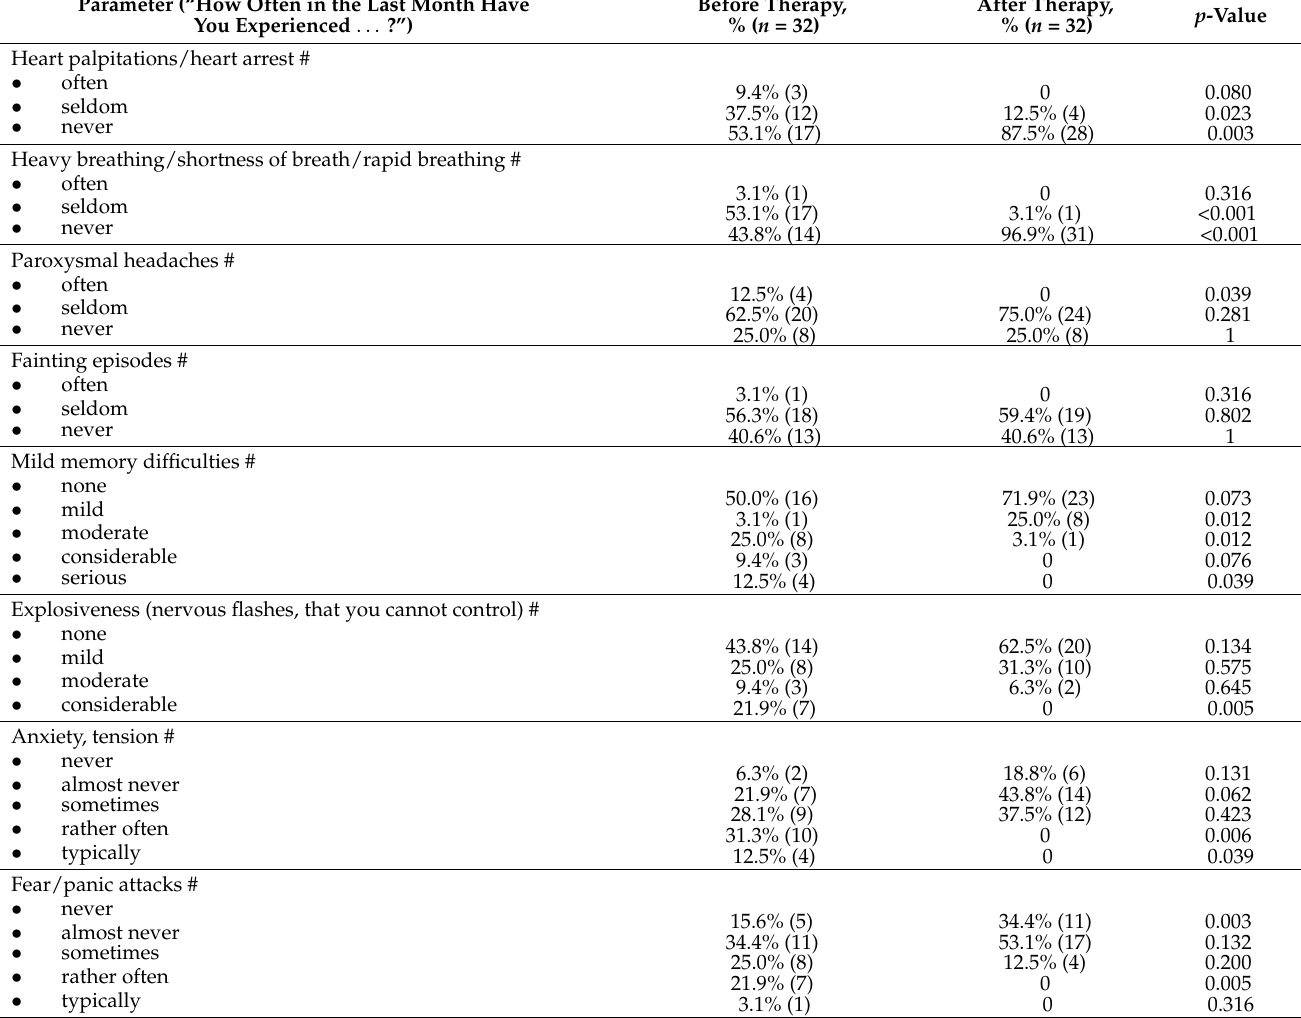
Table 2. Cognitive, affective symptoms and negative emotional sensations before and after dienogest